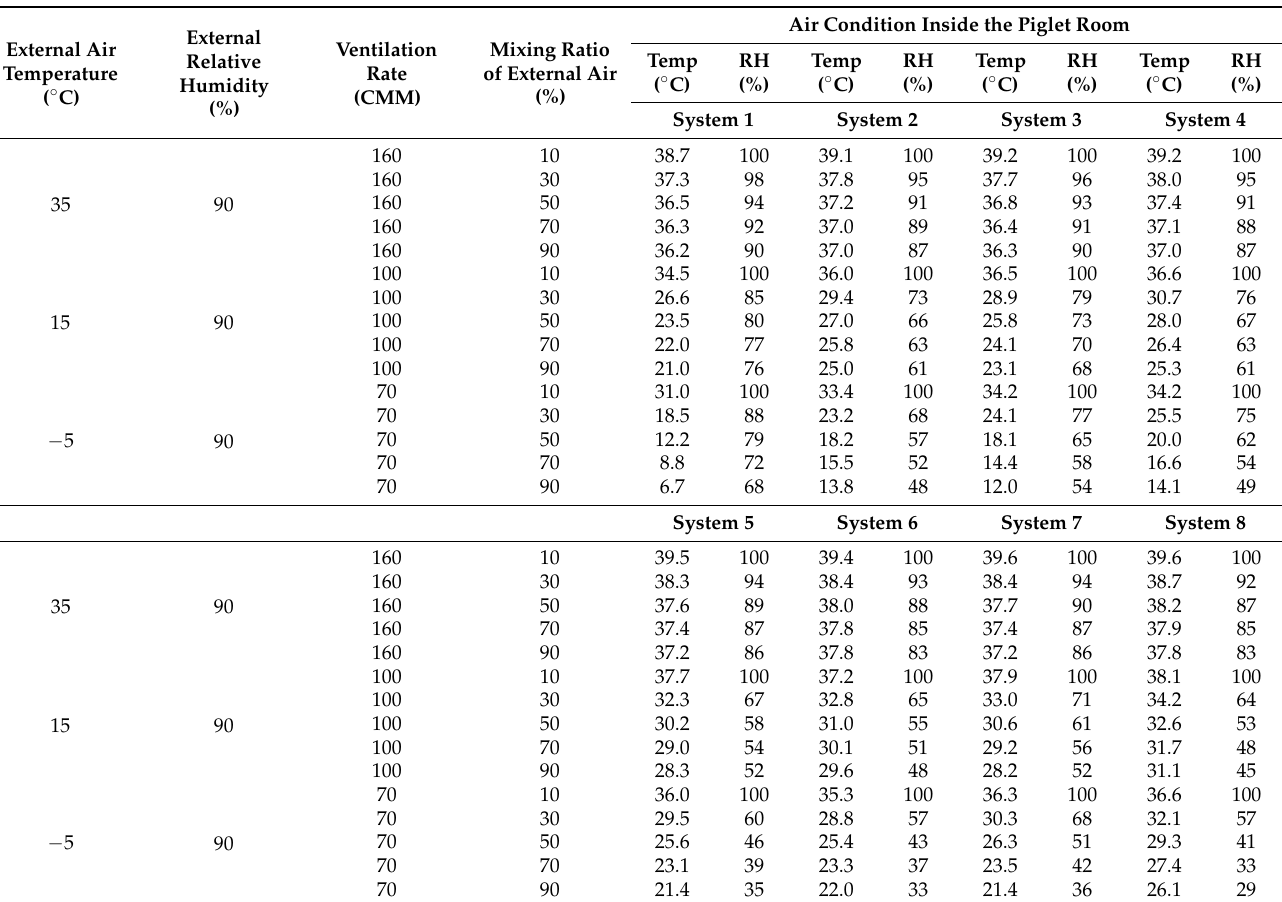
Table 6. Computed results of internal air temperature and relative humidity of the piglet room with the ARVS according to the external conditions, ventilation rates, and mixing ratio of external